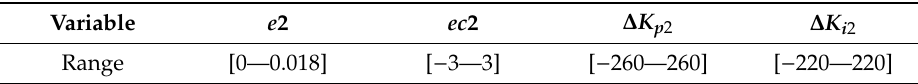
Table 3. Ranges of the input and out variables for O 2 . Table 4. Fuzzy rules for proportional gain Δ𝑲 𝒑 in the fuzzy control algorithm.